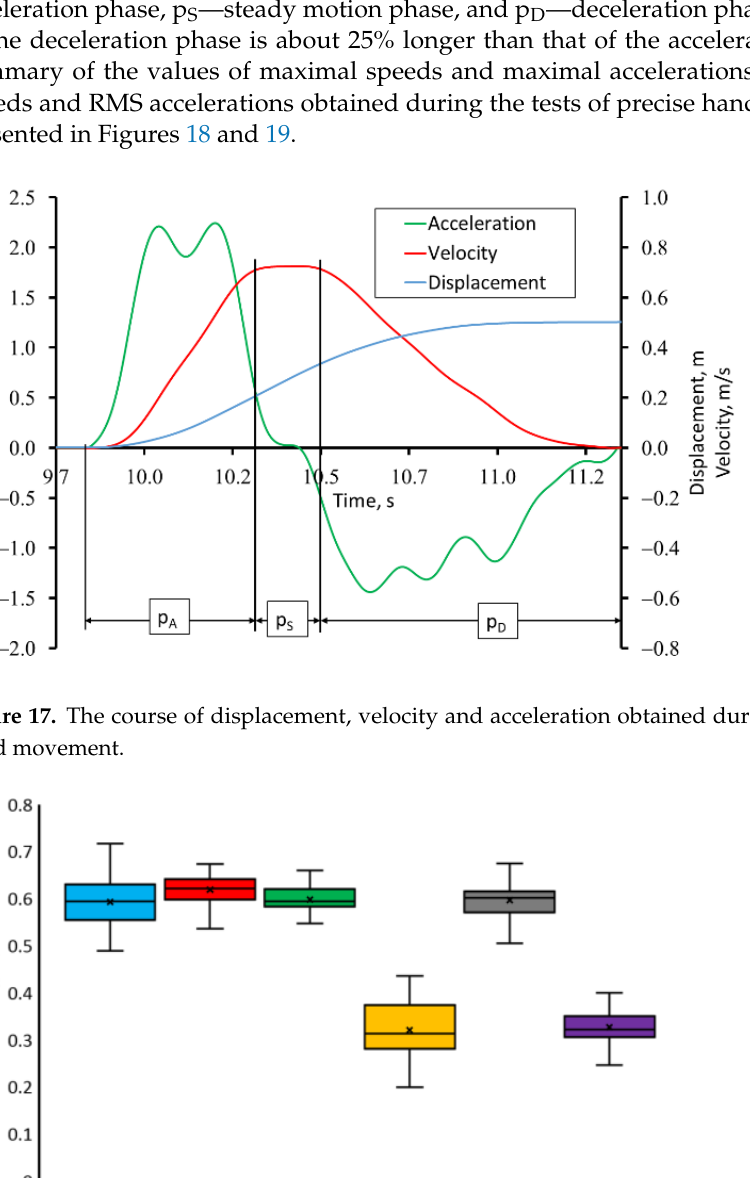
Figure 19. Summary of the values of maximum acceleration and RMS acceleration obtained during tests of precise hand movement. Analyzing the graphs (Figures 17 – 19), it can be seen that the median value of maxi- mal accelerations in the acceleration phase (2.3 m/s 2 ) is less than half the median of maxi- mal acceleration values in the acceleration phase obtained in the study of reaching